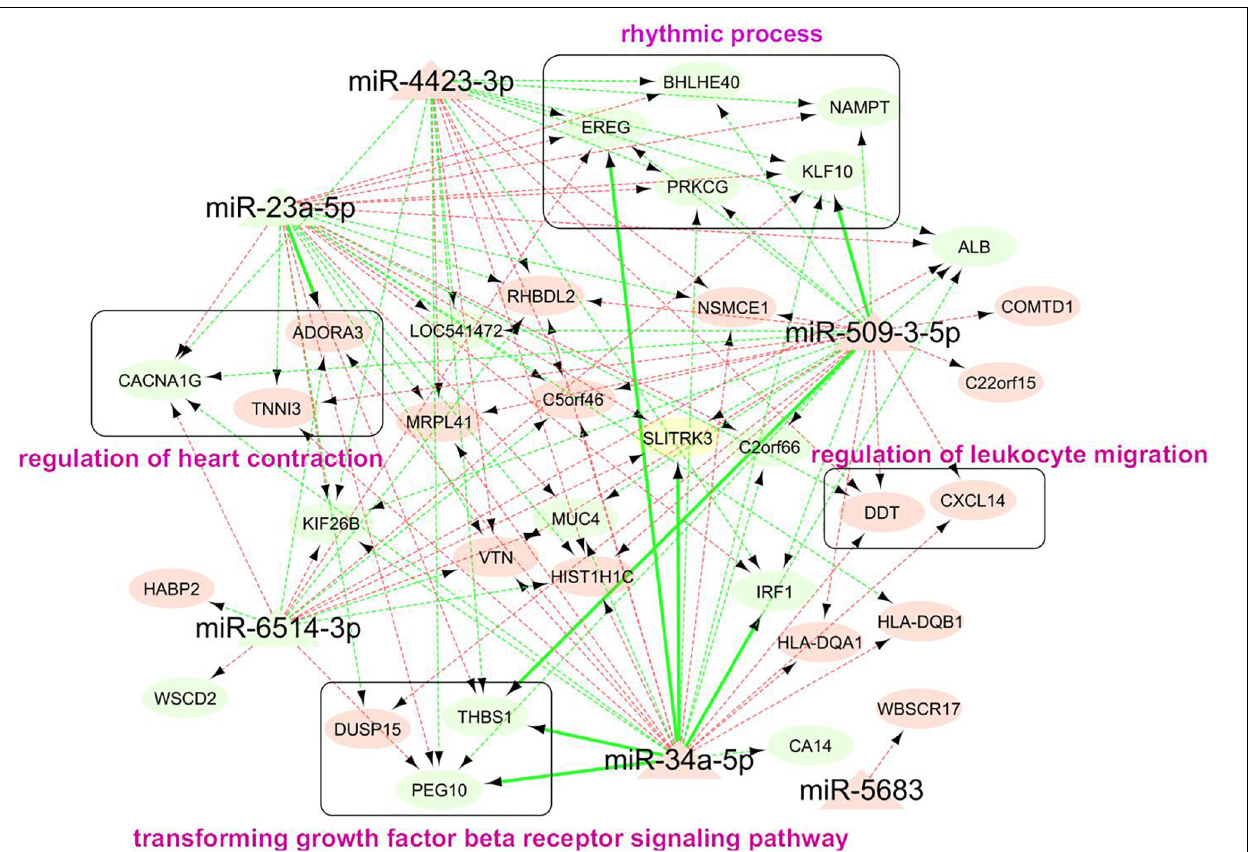
FIGURE 5 | Network analysis of 114 miRNA-mRNA pairs associated with human AA. Each node represented a miRNA (triangle shape) or gene (oval shape). The color of node indicated whether the expression of a miRNA or gene increased (light red) or decreased (light green) in older group. The color of edge indicated the negative (light green) or positive (light green) correlation between miRNA and downstream gene. Edge with sold line indicated direction interaction between miRNA and gene, i.e., gene was a predicted target of miRNA and it negatively correlated with expression of miRNA. Edge with dashed line indicated miRNA-mRNA pairs with indirect correlation, that said, the gene strongly correlated with expression of miRNA ( P cor < 0.05) and AA (FDR < 0.05). The genes in round rectangle were highlighted by gene set enrichment analysis ( Supplementary Table S3